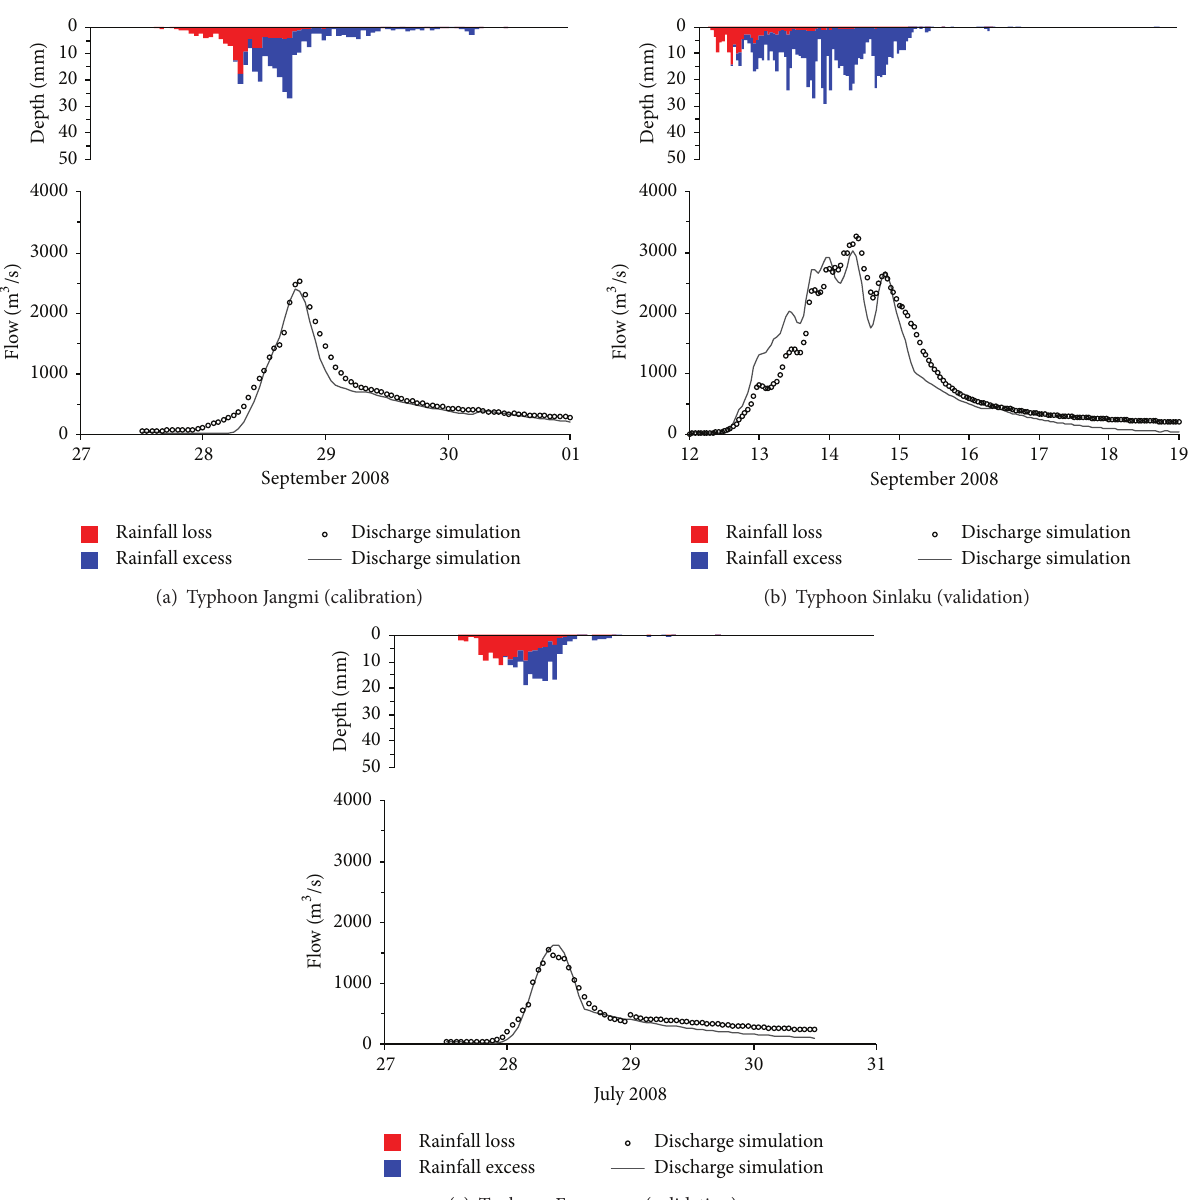
Figure 4: Observed and simulated hydrographs during (a) Typhoon Jangmi, (b) Typhoon Sinlaku, and (c) Typhoon Fungwong. The MAEs of model calibration and validation were 101.0, 224.8, and 84.8 m 3 /s. The result proves that the calibrated HEC-HMS model provides confident estimations for the timing and value of the peak flow and for the cumulative water volume into the reservoir. The SCS-CN method was selectedtoestimaterainfallloss,includinginterception,depressionstorage,infiltration,evaporation,andtranspiration.Thismethodestimates precipitation excess as a function of cumulative precipitation, soil cover, land use, and antecedent